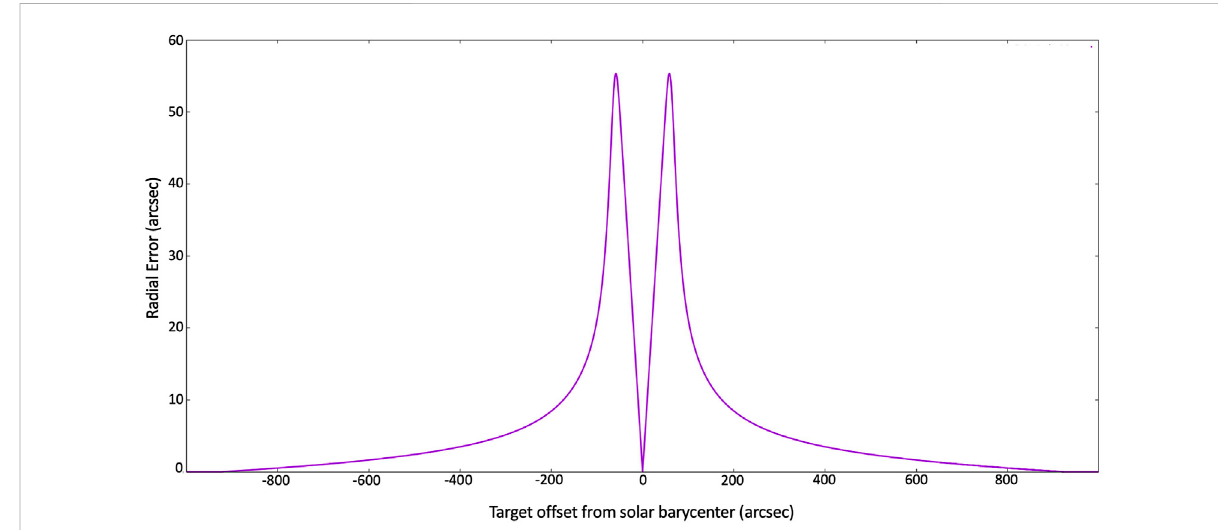
FIGURE 5 Example of the pointing ramping that results from the application of the GR delay tracking correction every 30 s. The (A) shows the change in pointing for the duration of an SB. The (B) shows a detail in which the ramping is vividly illustrated.